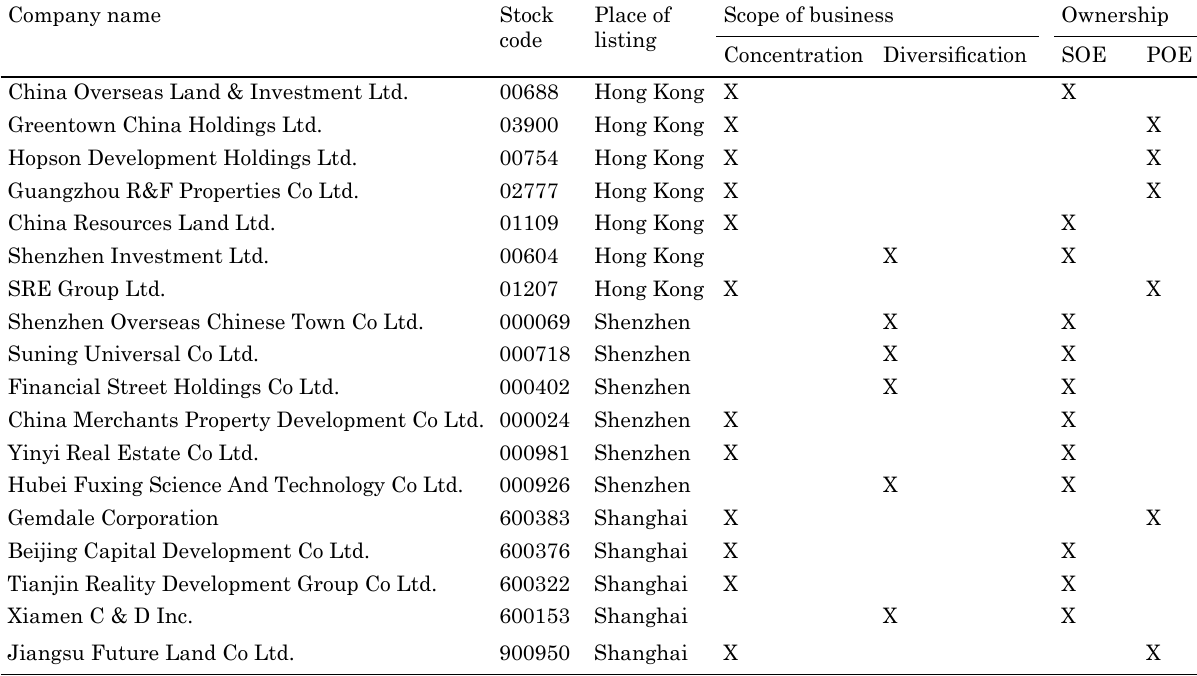
Table 2. The 18 selected mainland property